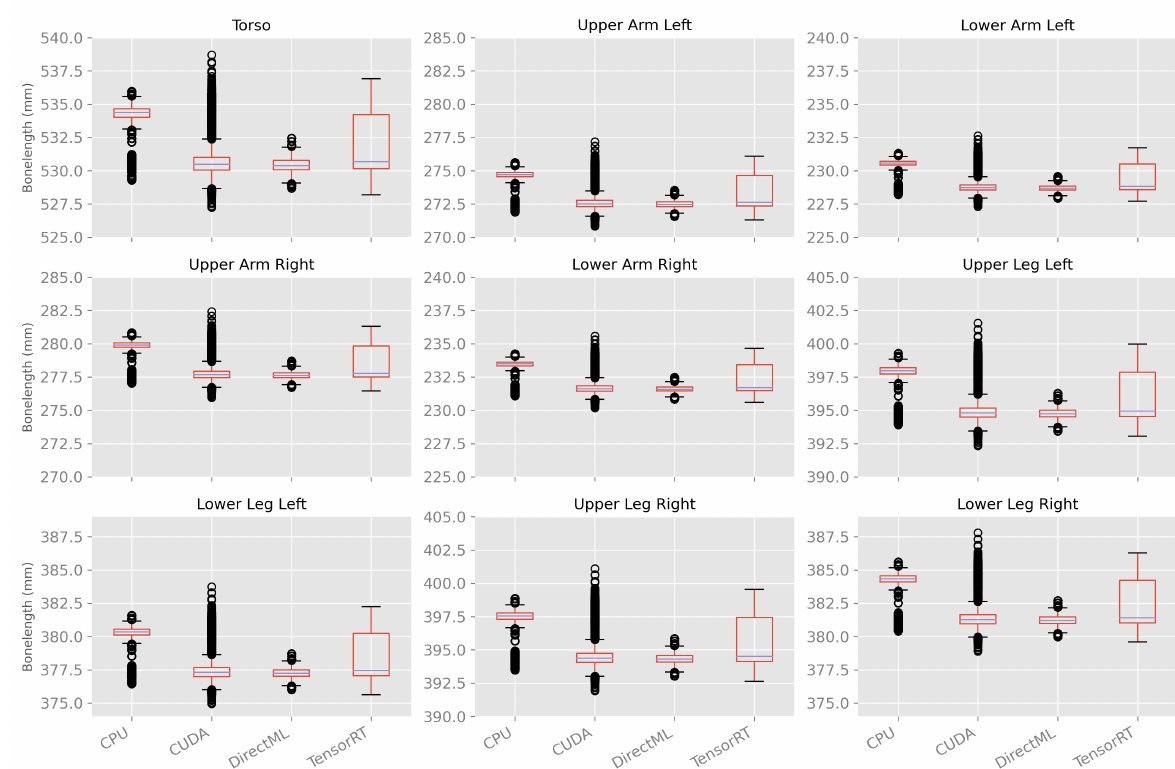
Figure 12. Box plots of bone length using 100 body tracking runs for all four processing